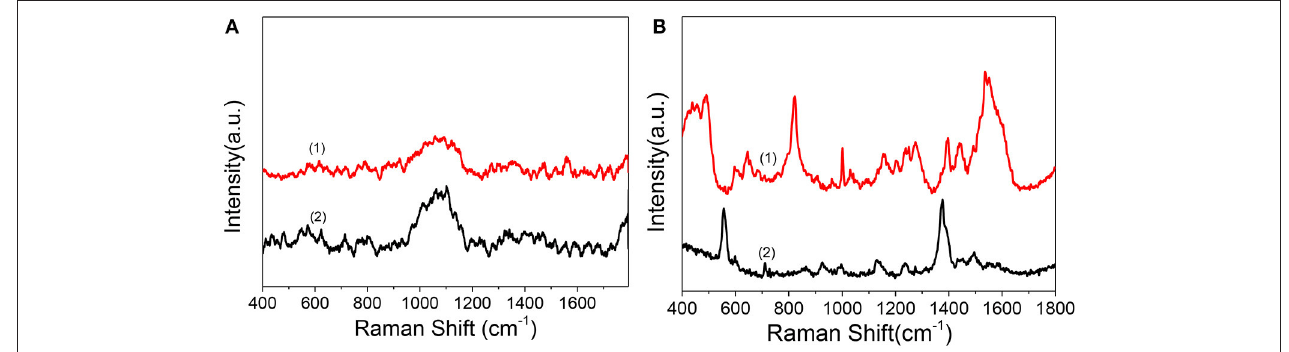
FIGURE 5 | (A) Raman spectrum (1) and SERS spectrum of Ce6 solution (2) measured after mixing AuNRs (0.3 mL, 0.1 nM) with the Ce6 solution (0.3 mL, 1.2 µ M). (B) (1) SERS spectrum of B16 cell nucleus with the enhancement of nuclear targeting nanoprobes (0.1 nM). (2) SERS spectrum of 1.0 nM of nuclear targeting